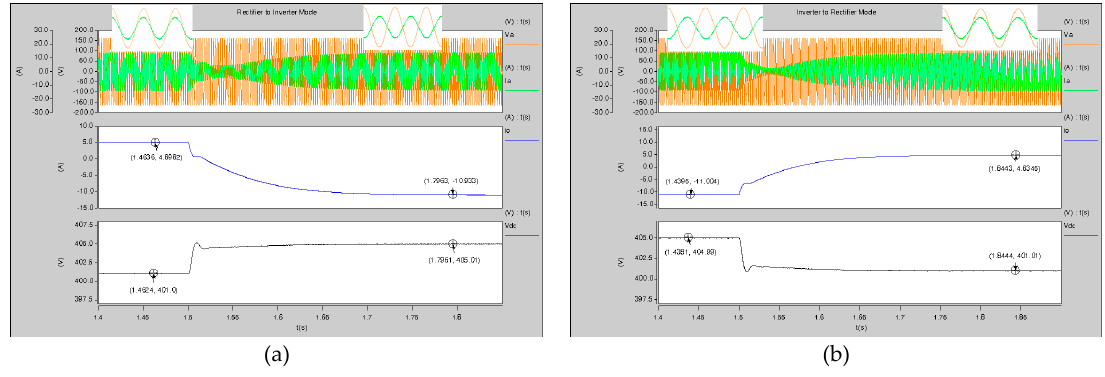
Figure 13. Bidirectional power flow ( a ) rectifier to inverter mode; and ( b ) inverter to rectifier mode.